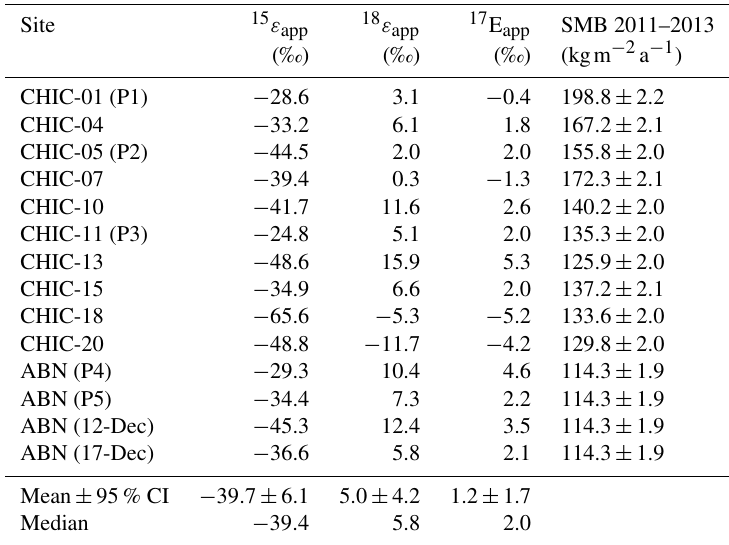
https://doi.org/10.5194/acp-22-15637-2022 Atmos. Chem. Phys., 22, 15637–15657,